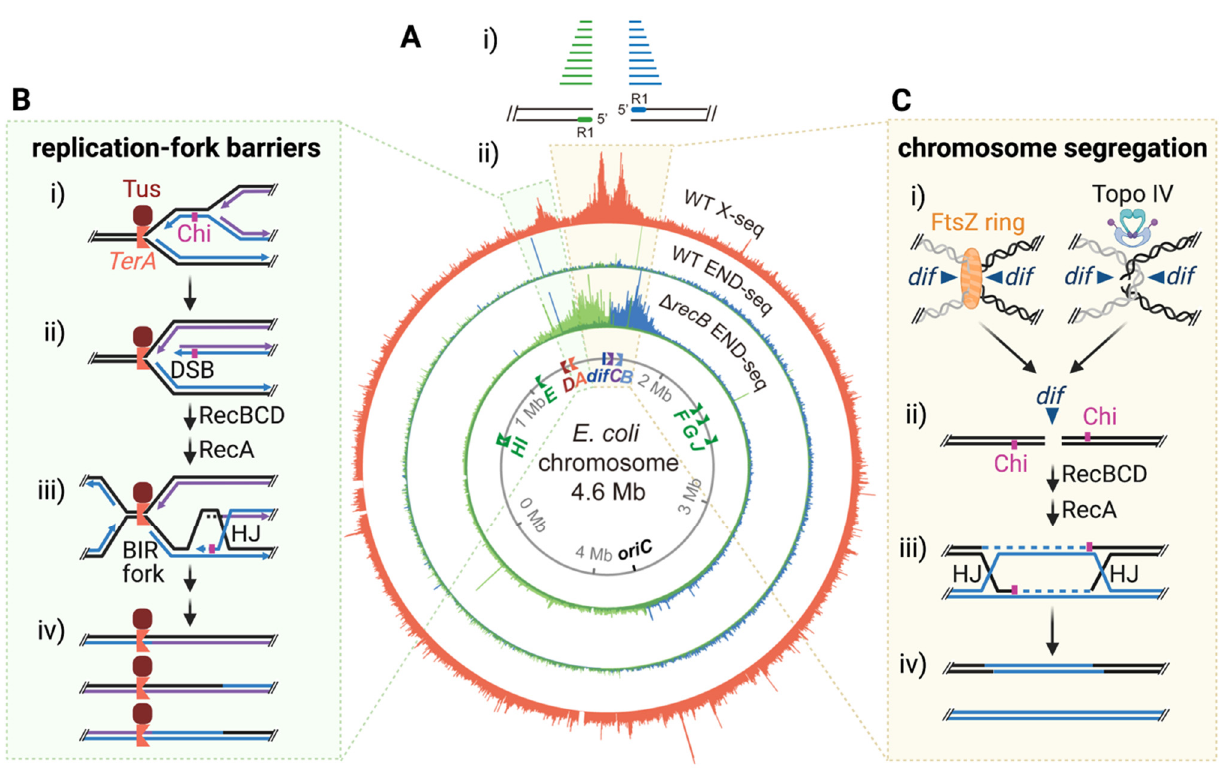
Figure 3. Genome ‐ wide mapping of spontaneous HJs and DSBs reveal three major E. coli fragile sites. ( A ) ( i ) Diagram of END ‐ seq color coding, green and blue indicate DSB ‐ end polarity. ( ii ) Circular maps of spontaneous HJs (orange), obtained via X ‐ seq [16,18], and DSB ends located using END ‐ seq [38], in DSB repair ‐ proficient wild ‐ type (WT) and repair ‐ deficient ∆ recB cells [16]. DSBs at Ter sites are one ‐ ended; DSBs surrounding dif , the site of chromosome decatenation, appear to be two ‐ ended. (One ‐ ended DSBs in different cells in the population are also possible.) ( B ) Tus ‐ Ter replication ‐ fork barriers cause fork collapse and one ‐ ended DSB formation ( i , ii ) [16], a “stop ‐ and ‐ wait” model. ( iii ) DSBs are repaired by replication primed by DNA ‐ break repair (break ‐ induced replication or BIR) and converging forks ( iv ). ( C ) dif ‐ proximal DSBs form during cell division, probably by guillotining by the FtsZ ring (septum) and/or topoisomerase (Topo) IV half ‐ reactions ( i ) [16]. DSBs are repaired by HR in daughter cells after cell division occurs ( ii – iv ). Dashed lines, newly synthesized DNA.